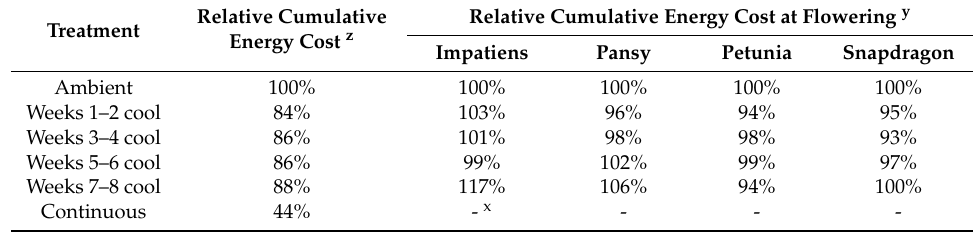
Table 3. Percent energy costs, relative to ambient conditions, calculated in Virtual Grower 3.0.9 using parameters specified [24]. Ambient conditions were 22/18 ◦ C air temperature, 14 h photoperiod, and ambient irradiance + 75 µ mol · m − 2 · s − 1 supplemental lighting from high-pressure sodium